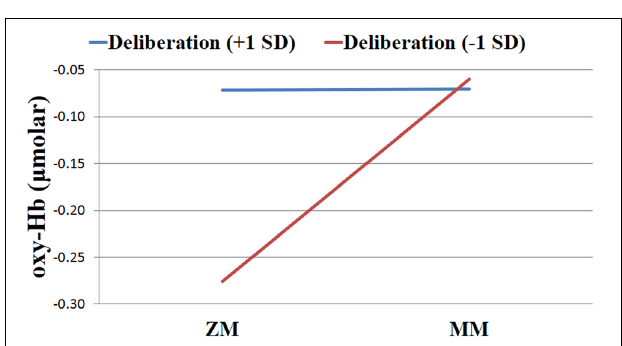
FIGURE 7 | Levels of oxygenated hemoglobin (oxy-Hb) for individuals high vs. low in Deliberation in the left dorsolateral prefrontal cortex across zero-move (ZM) and multiple-move (MM) conditions on the Scarborough adaptation of the Tower of London task.